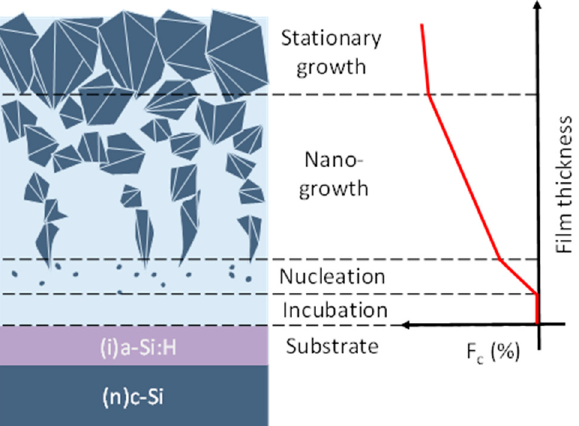
Figure 1. Schematic cross-sectional sketch of the nanocrystalline silicon layer structure for a (i)a-Si:H-coated substrate. On the right, the F C evolution of the nanocrystalline phase is depicted as function of the film thickness for the different stages: incubation, nucleation, nanogrowth and stationary growth. Figure from [47].